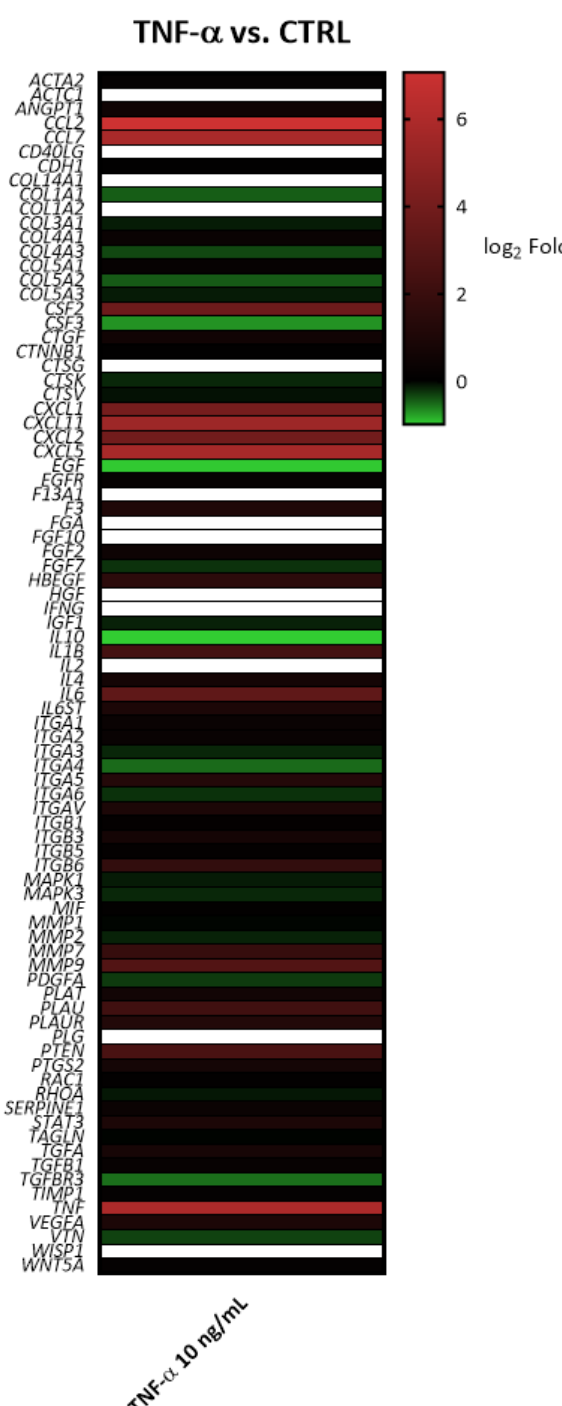
Figure 1. Heatmap depicting the alterations of gene expression induced by TNF-α (10 ng/mL, 6 h). The color scale represents gene upregulation ( red ) and downregulation ( green ) compared to the control (log 2 fold change = 0, black ). In white, genes present in the panel but not expressed in the experimental model.